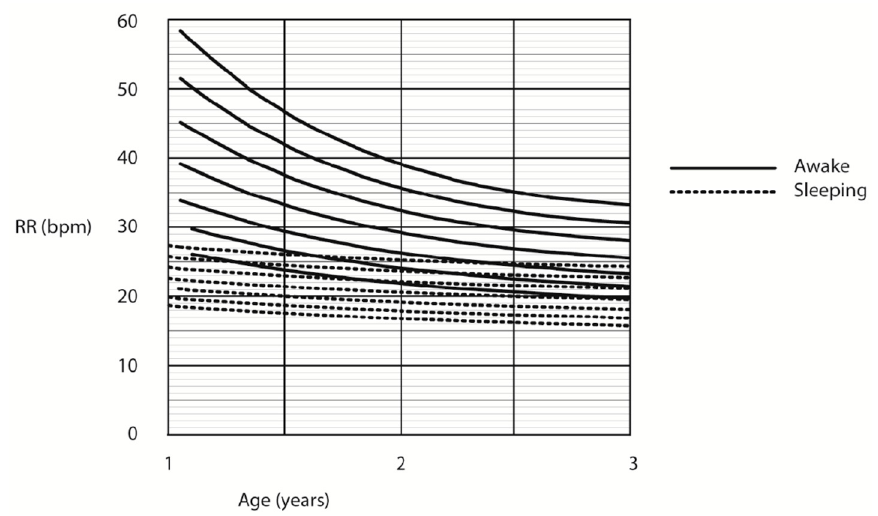
Figure 5. Respiratory rate centile chart in asleep and awake children (centiles—3rd, 10th, 25th, 50th, 75th, 90th, 97th).